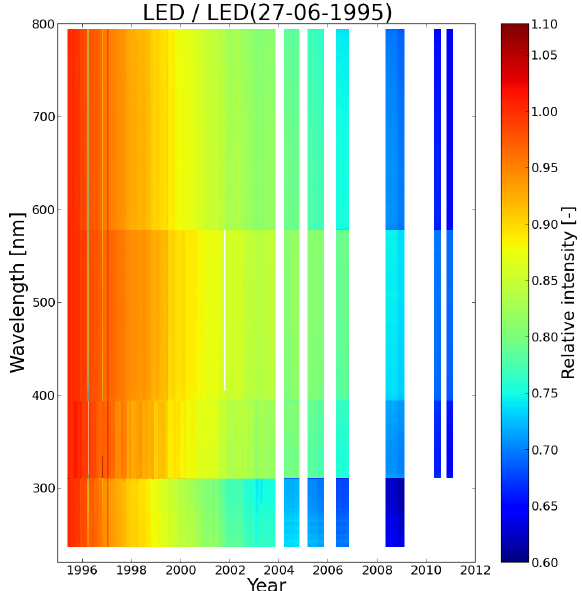
Figure 18. Relative intensity of LED spectra as a function of time ( x axis) and wavelength ( y axis) with respect to a reference spec- trum from 27 June